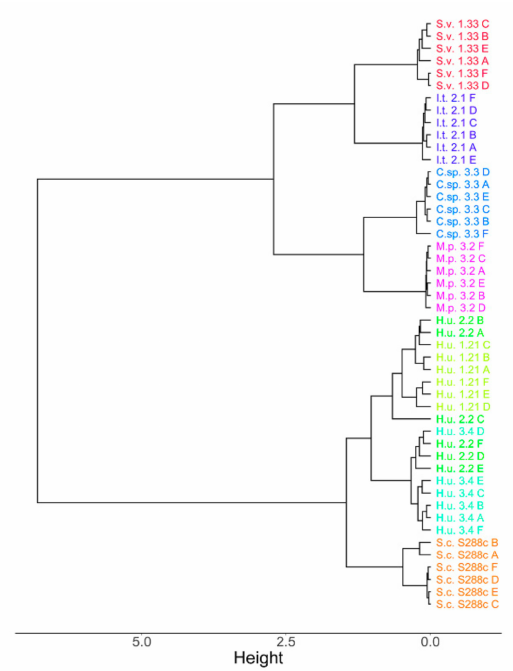
Figure 1. Hierarchical clustering dendrogram obtained using Spearman distance and the Ward clustering algorithm including all the annotated metabolites for each of the six biological replicates (A to F) per